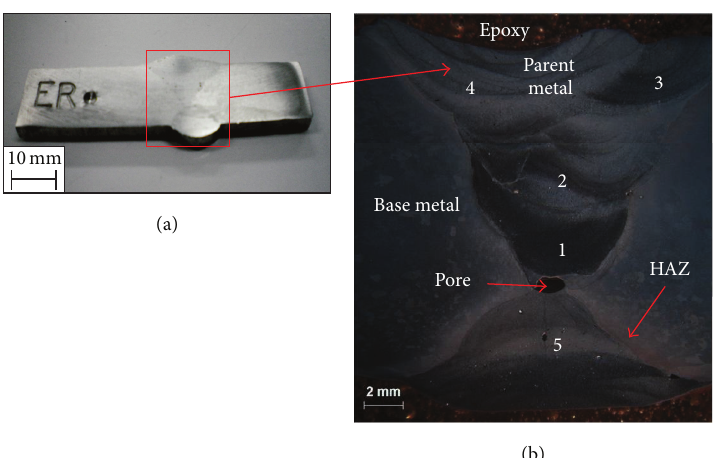
Figure 3: AA6061 welded sample before being subjected to oxidation test consisting of (a) optical image and (b) macrostructure showing parent, fusion metal, and heat affected zone (HAZ).